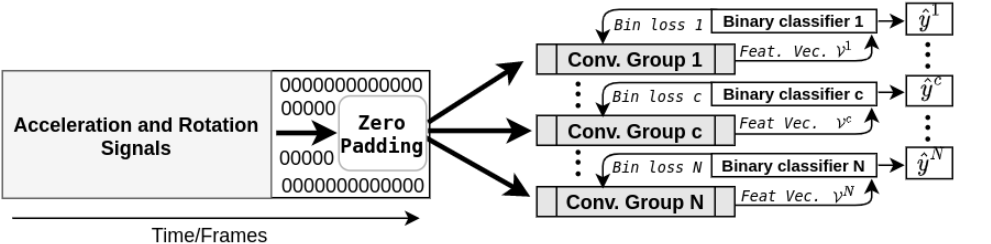
Figure 1. An high-level representation of the network architecture and learning mechanisms. Each class has its own convolution group that does the feature extraction and its own binary